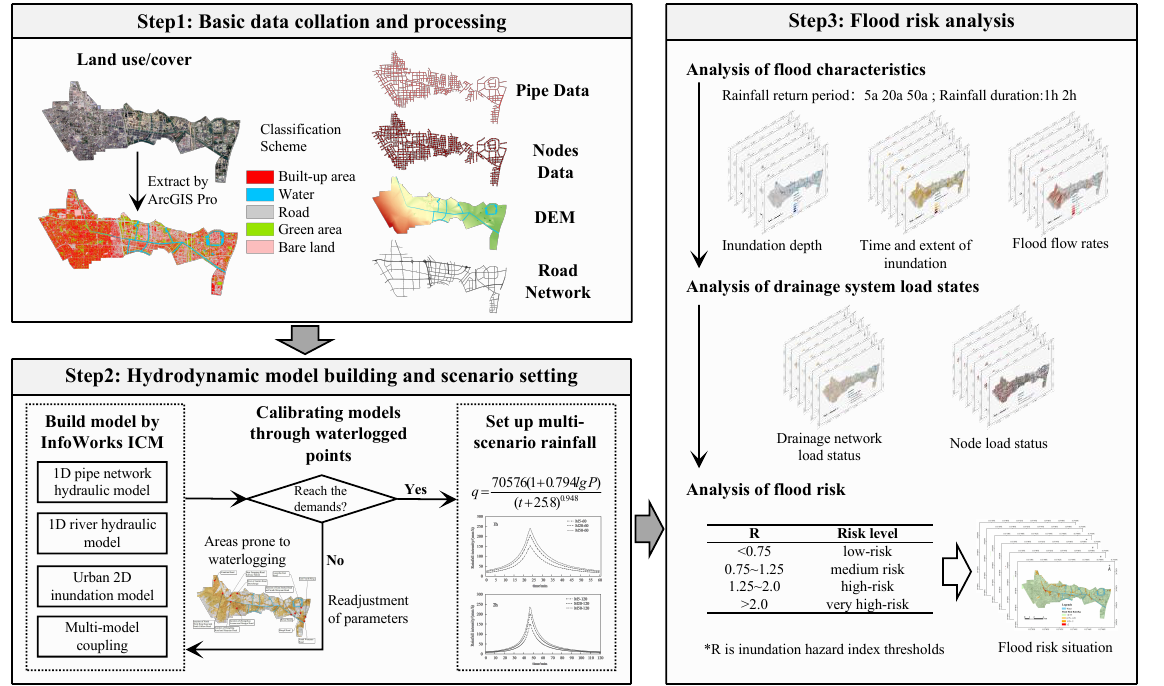
Figure 4. Distribution of simulated results compared to measured water accumulation